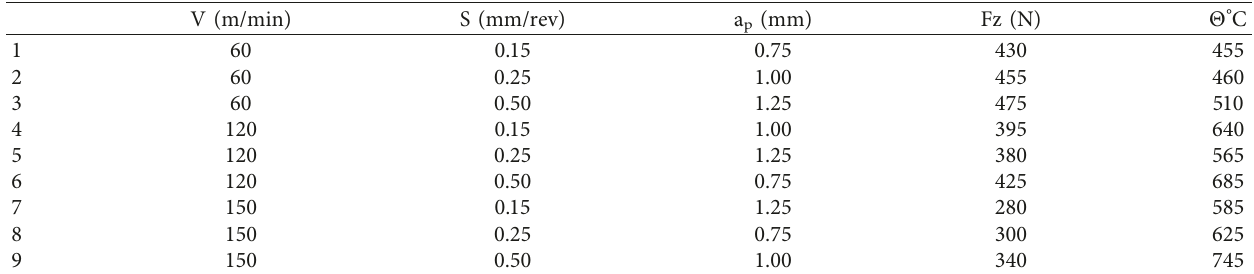
Figure 3: Temperature generation in the machining zone. (a) Temperature: simulated at (V) 60m/min, (S) 0 .15mm/rev, ap: 0.75 mm (b) Temperature: simulated at (V) 120m/min, (S) 0.25mm/rev ap:1.25mm, and (c) Temperature: simulated at (V) 150m/min, (S) 0.55mm/rev a p : 1.00mm. Table 3: DEFORM 3D simulated